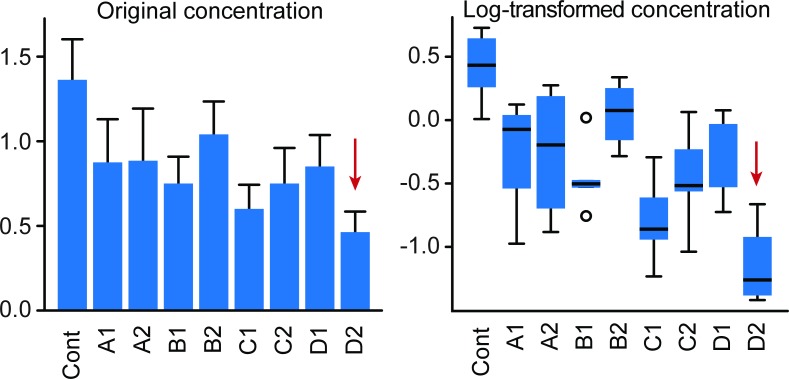
Histogram representing the mean Sphingosine‐1‐Phosphate Phosphatase 1 activity (ratio SGPP1) in different groups.Sphingolipid metabolism is decreased in HIV patients compared to healthy controls (T Test = 0.012128) particularly in the INR group after antiretroviral treatment (arrow) as demonstrated by the ANOVA analysis of SGPP1 activity (p = 2.5266E-7, -log10(p) = 6.5975, FDR = 2.8123E-6). Y Axis is depicting micro molar plasma concentrations. Cont = controls; A1 and A2 are Elite controlers during recent infection and after one year of enrollment; B1 and B2 = Rapid Progressors during recent infection and after one year of enrollment; C1 and C2 = Immunologic Responders before treatment and after one year of treatment, D1 and D2 = INR before treatment and after one year of treatment.